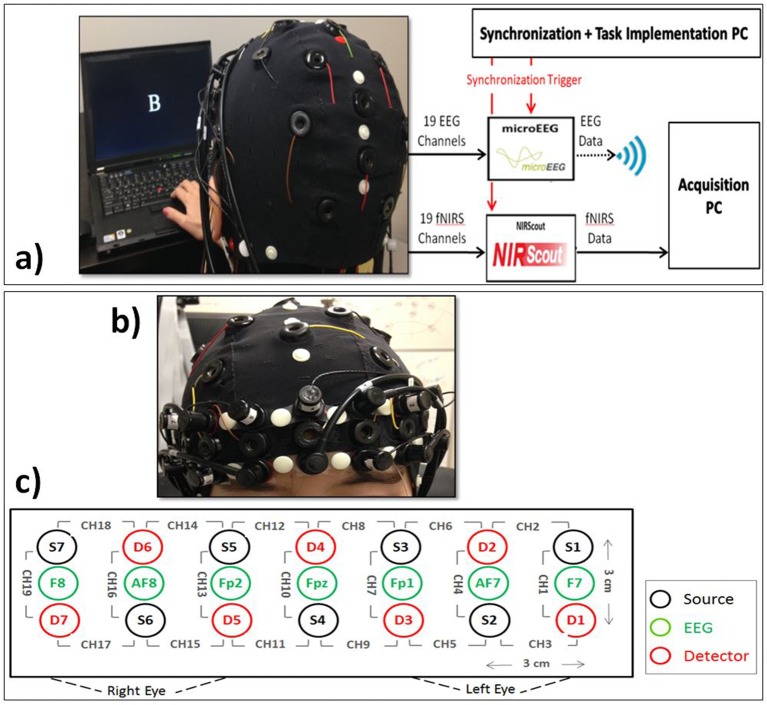
(a) EEG+fNIRS recording setup. Subject interaction with the computer, synchronization of EEG and fNIRS signal, recording of EEG and fNIRS signals, and data transmission to the acquisition platform. (b) Coronal view of the subject showing the close view of the placement fNIRS optodes and EEG electrodes. (c) Topographical view of fNIRS sources (Si, black) and detectors (Di, red) and EEG electrodes (green). Each pair of source and detector separated by 3 cm creates a channel (CHi). We used the signals from F7, Fpz, and F8.